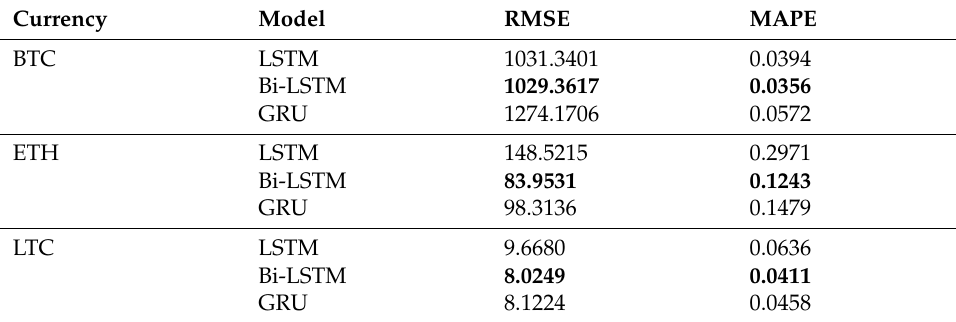
Table 2. Performance results for the proposed